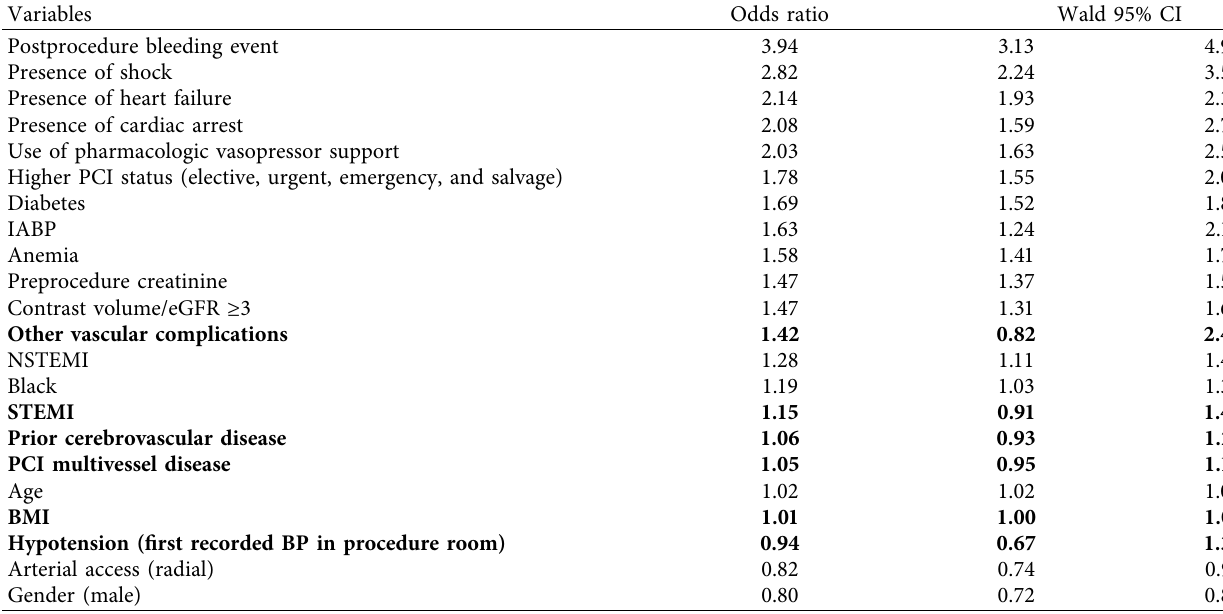
Table 1: Odds ratios from logistic regression on AKI after PCI with propensity score weights.